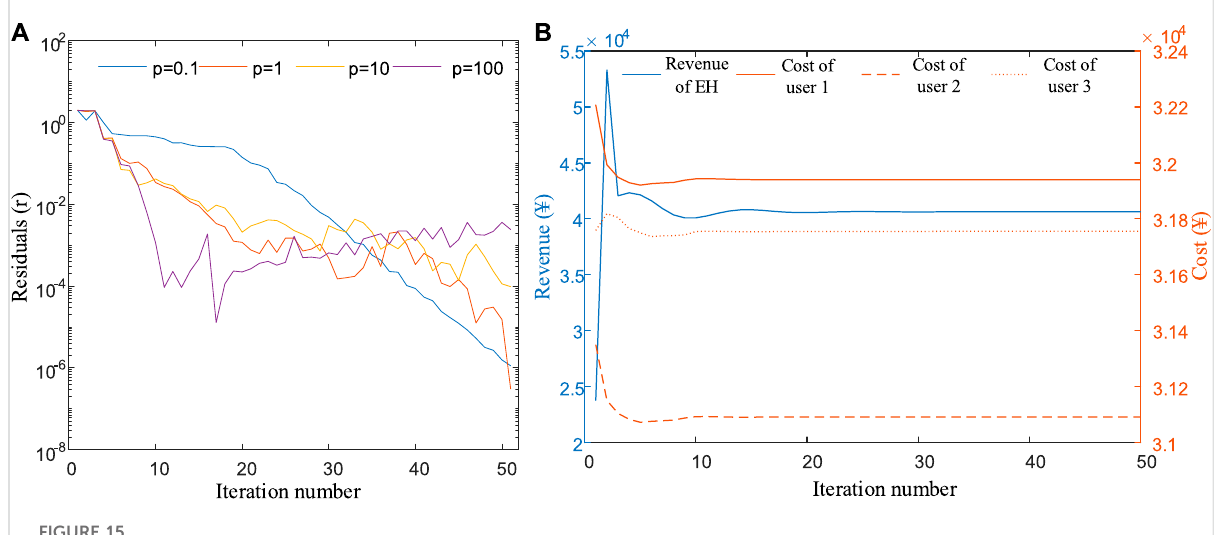
FIGURE 15 The convergence effect of the decentralized robust optimization algorithm.